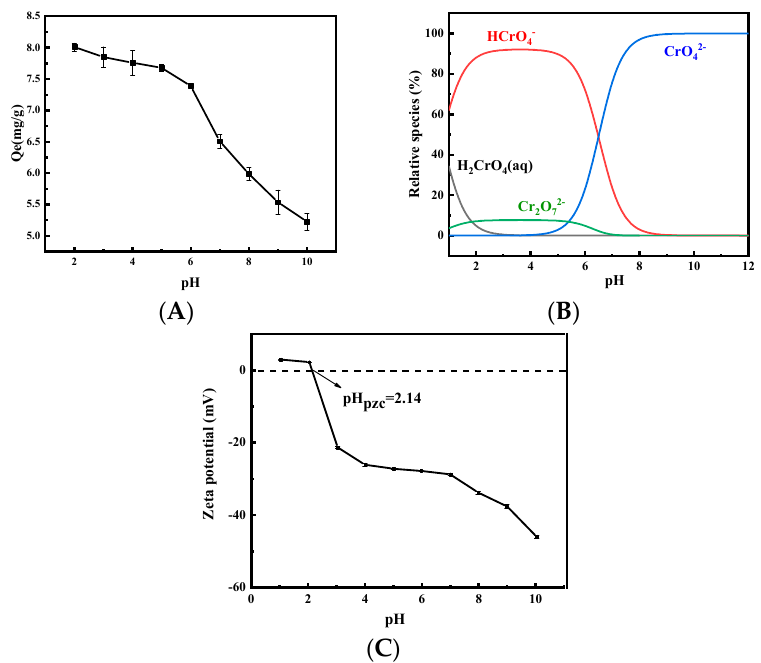
Figure 5. ( A ) Effect of initial solution pH on adsorption performance ( C 0 = 50 mg/L, time = 6 h, and temperature = 25 °C); ( B ) the existing forms of Cr(VI) in the solution at different pH levels; ( C ) zeta potential of MHDB.